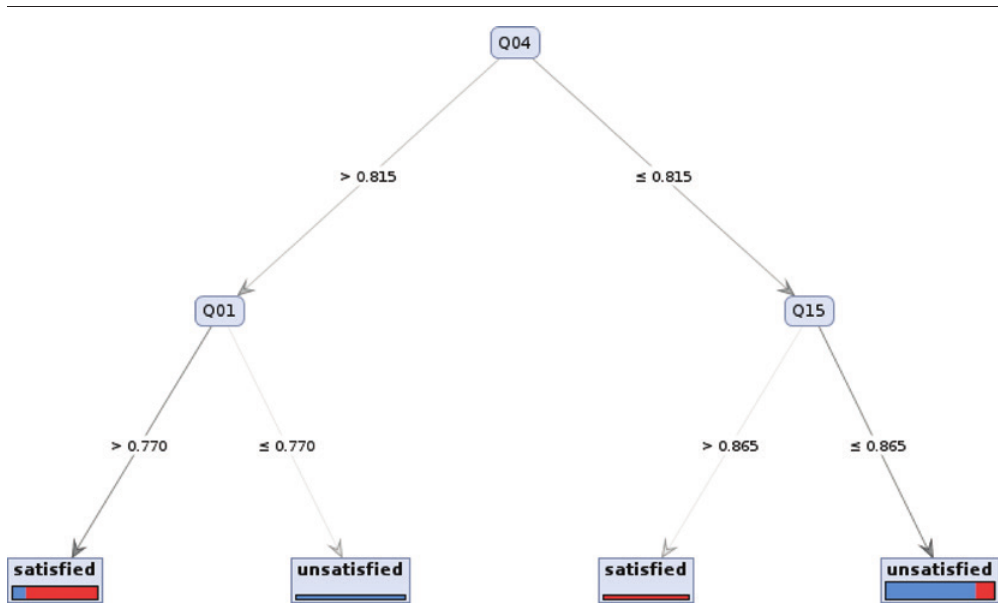
Figure 7: AI-generated tree model showing how Q22 satisfaction can be predicted from other NSS questions, in computer science, across the top half of providers by size